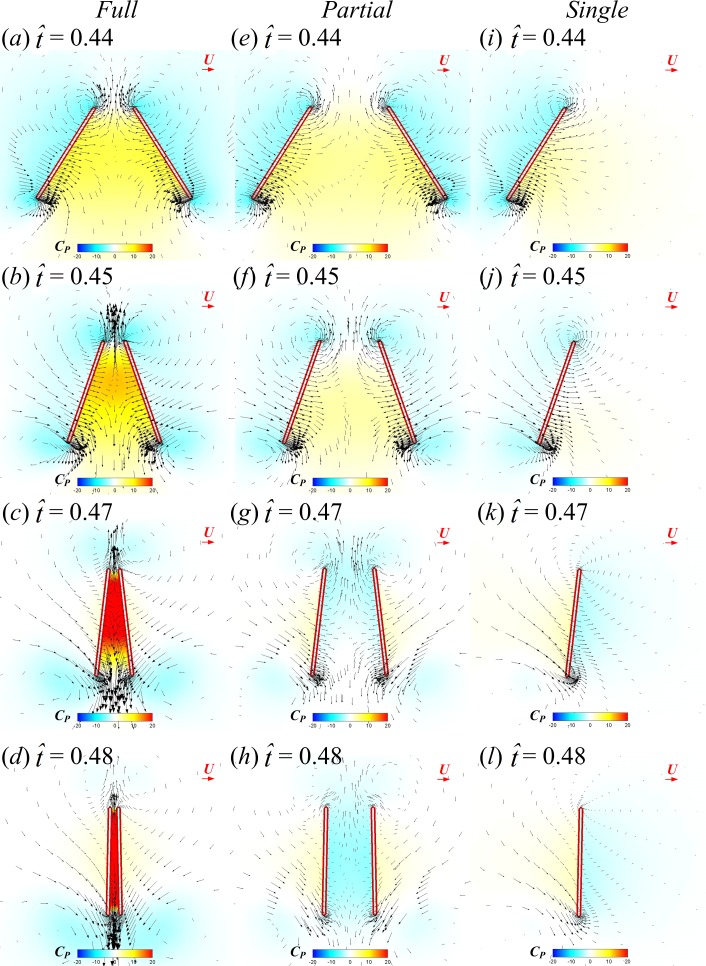
Velocity vectors and pressure distributions of the FCF case (A–D), PCF case (E–H) and SW case (I–L) in vertical plane at half-wing length for \documentclass[12pt]{minimal}
\usepackage{amsmath}
\usepackage{wasysym}
\usepackage{amsfonts}
\usepackage{amssymb}
\usepackage{amsbsy}
\usepackage{upgreek}
\usepackage{mathrsfs}
\setlength{\oddsidemargin}{-69pt}
\begin{document}
}{}$\hat {t}=0.44$\end{document}t ˆ=0.44, 0.45, 0.47 and 0.48 in the clap phase (red horizontal arrow indicates reference velocity).